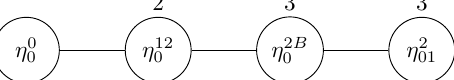
Figure 11 . Codimension-three enhancement of SU(2) (cid:2) G